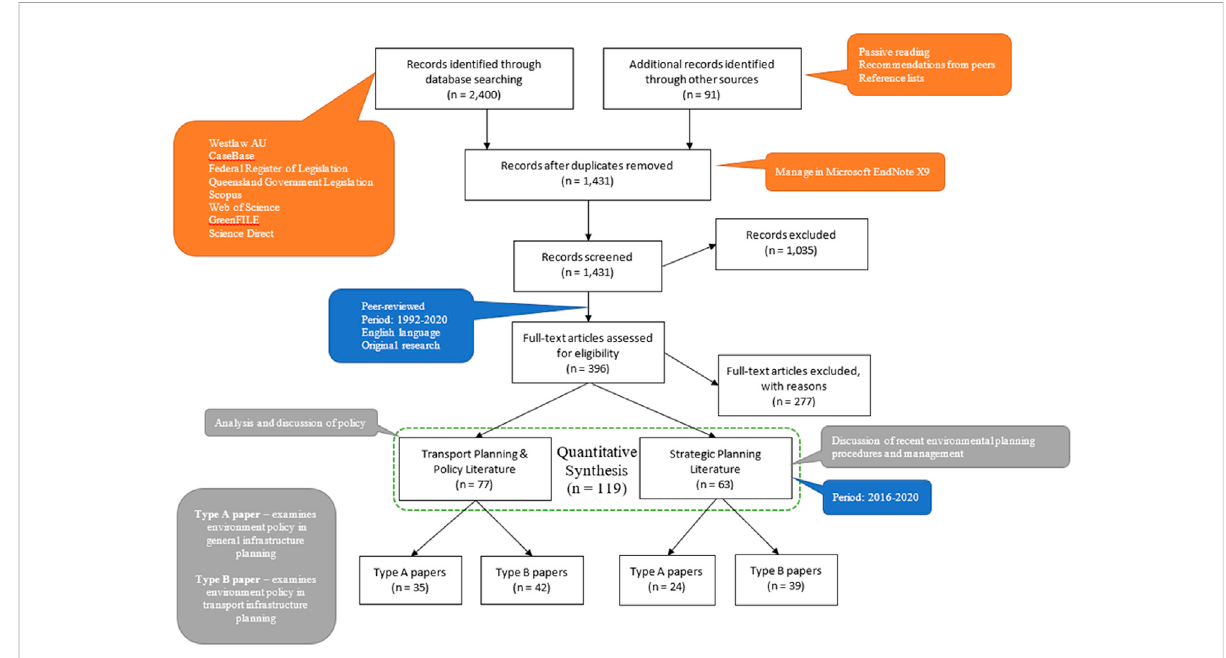
FIGURE 1 Preferred reporting items for systematic review and meta-analysis (Prisma-P) fl